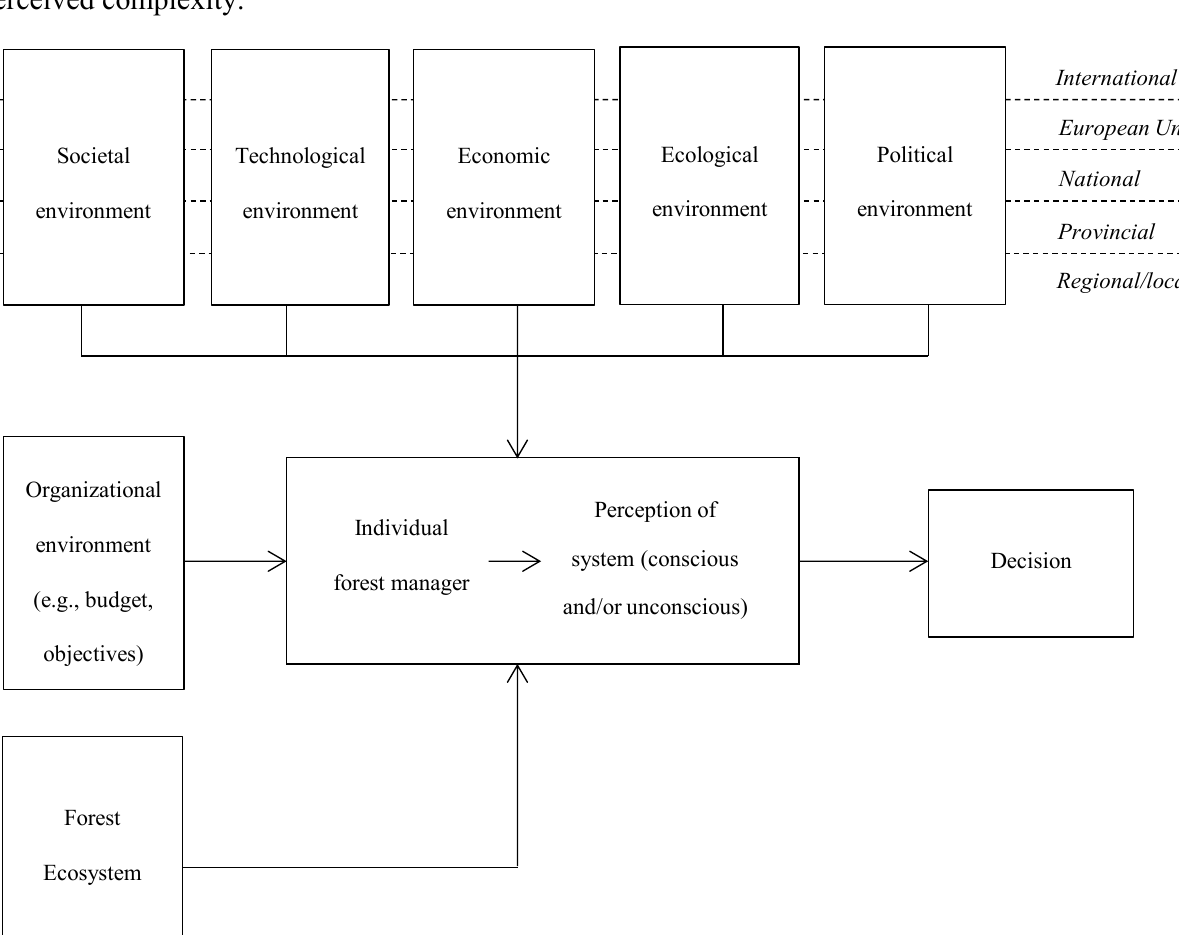
Figure 1. Theoretical framework of external factors possibly influencing decision-making in forest management (only the direct links between the factors and decision-maker are drawn; interrelations between factors are excluded from the research; the sizes of the shapes in the figure are not drawn to scale and thus bear no